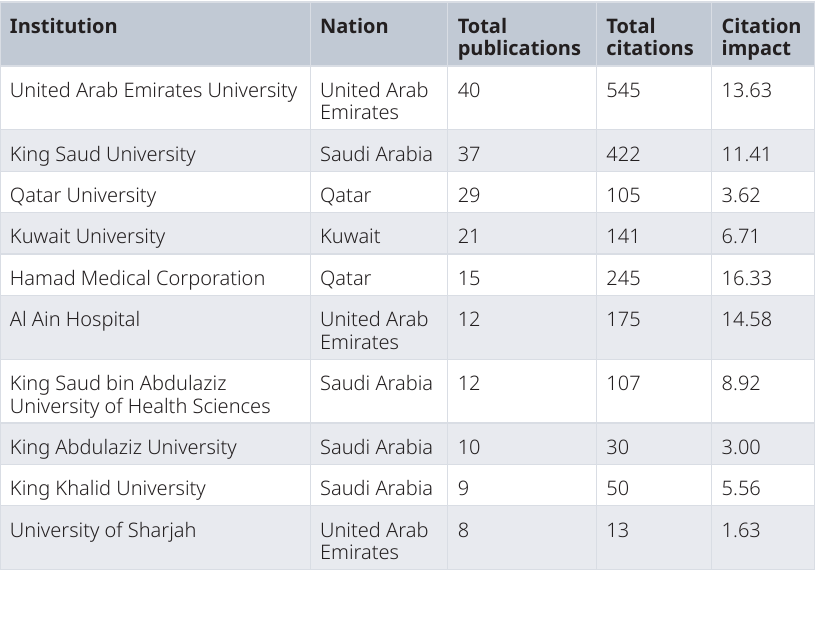
Table 4. Most productive individual authors for road traffic injuries research in the Gulf Cooperation Council region (1981–2019).